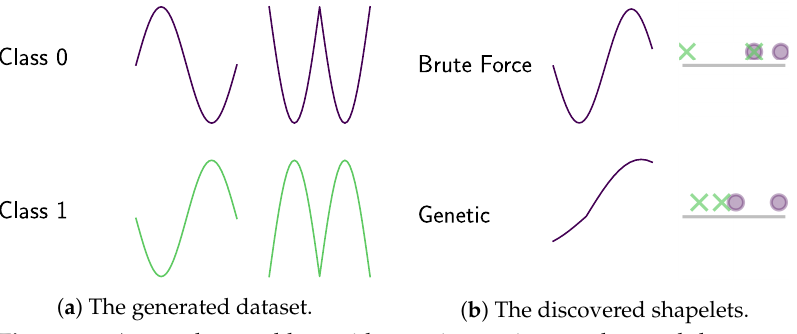
Figure 11. A two-class problem with two time series per class and the extracted shapelets with corresponding distances on an ordered line by a brute-force approach versus gendis .